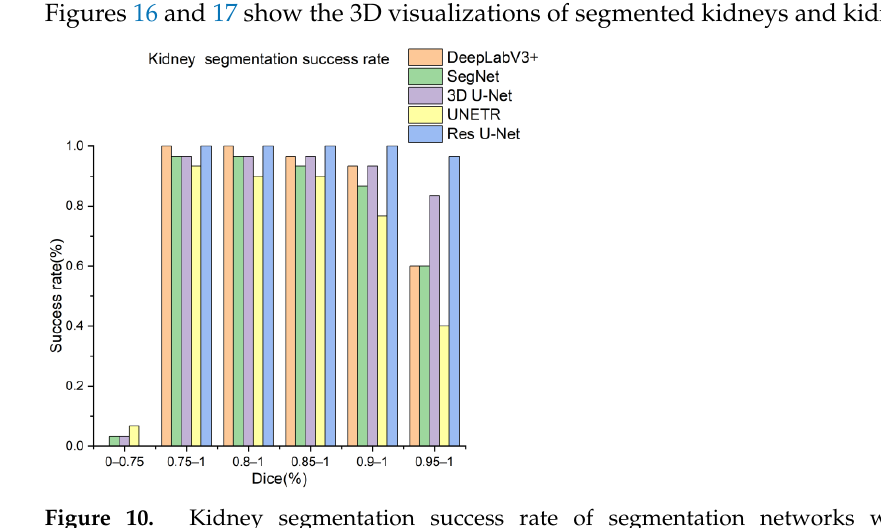
Figure 10. Kidney segmentation success rate of segmentation networks with proposed training scheme.